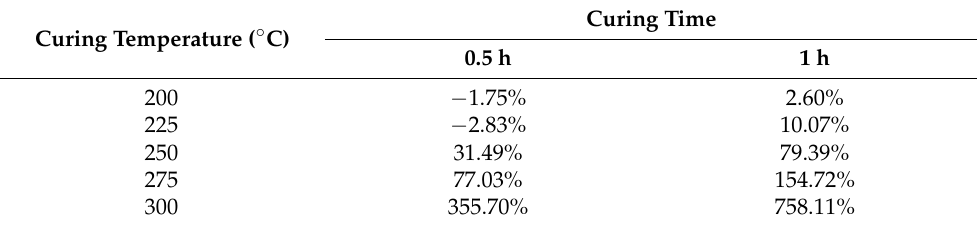
Figure 2. Changes in AZO resistance with different curing parameters. Table 2. Changes in resistance of samples cured for 0.5 h and 1 h at different temperatures, expressed as a